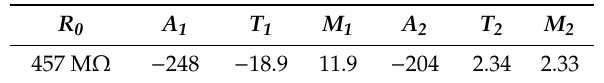
Table 4. P–R model Table 4. P–R model parameters. Table 4. P–R model parameters.